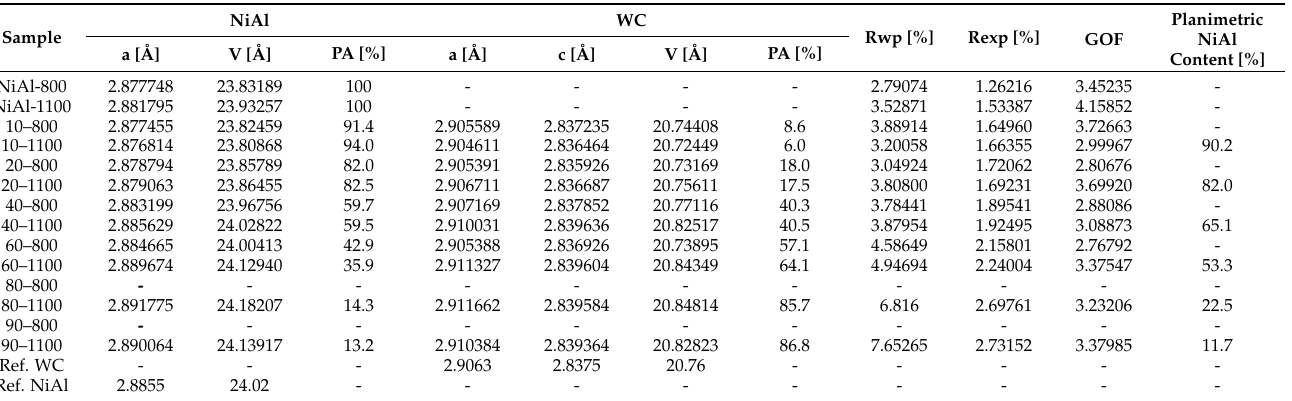
Table 5. Structural phase parameters and amounts determined by the Rietveld method collated with the planimetric phase estimation.